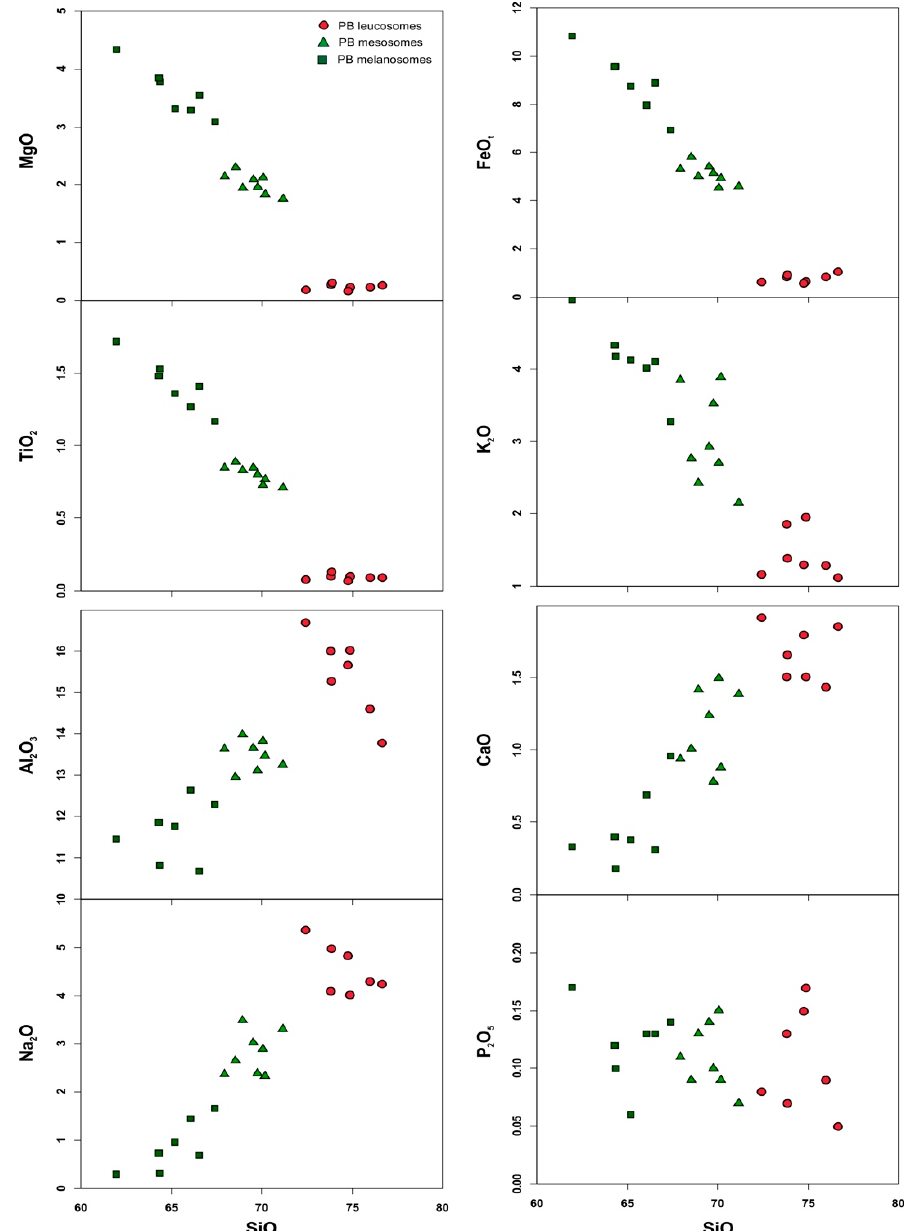
Figure 5. Harker diagrams for major elements (wt. %).